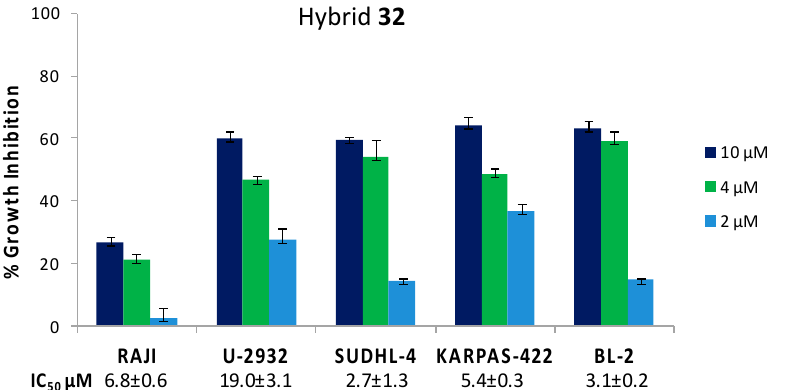
Figure 4. Antiproliferative activity of hybrid 32 against a selection of B-lymphoma cells at 10, 4, 2 µM concentration at 72 h incubation time. IC 50 values are expressed as the mean of three independent experiments ± SD.